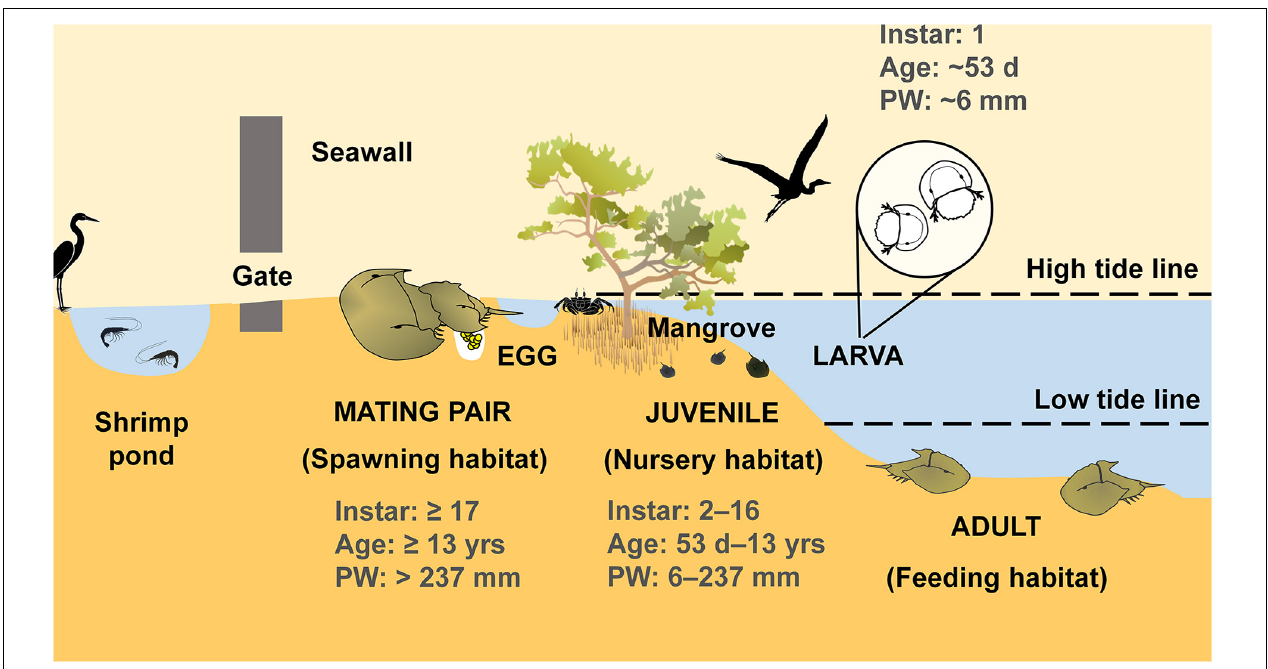
FIGURE 1 | Life cycle and the associated habitats for T. tridentatus . PW, prosomal width (size); d, day; yrs,